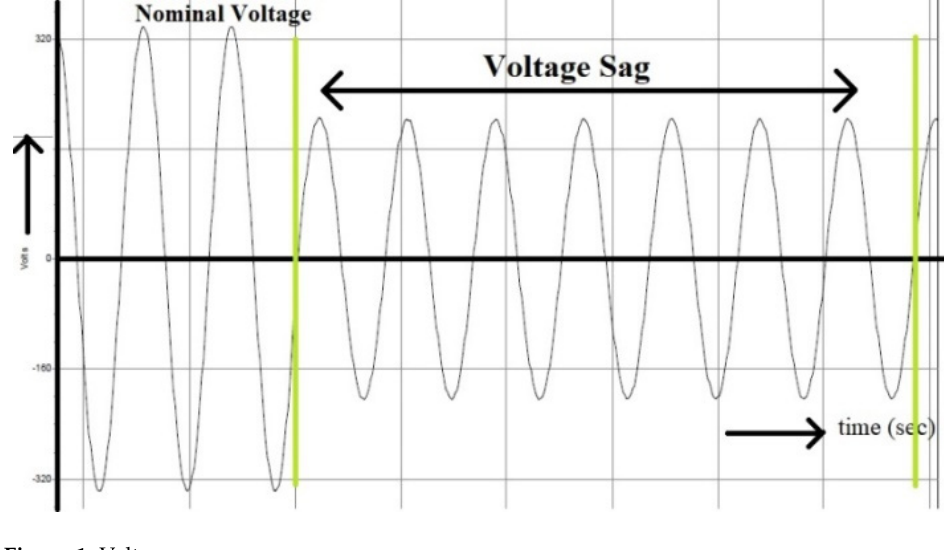
Figure 1. Voltage sag.